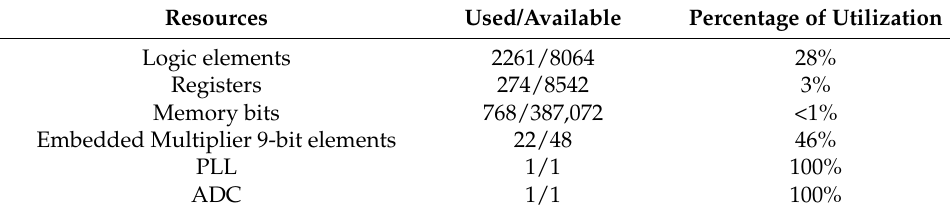
Table 2. FPGA resource utilization for predictive current control implementation.